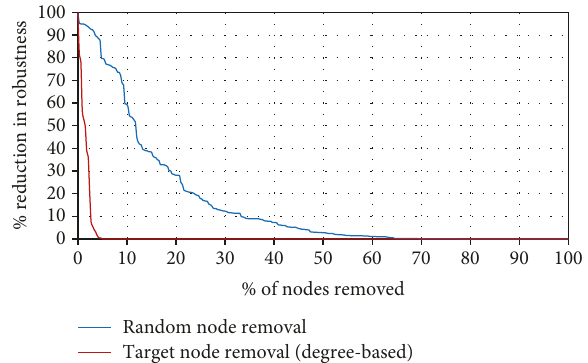
Figure 9: E ff ect of random and targeted (degree based) node removals on overall SCN